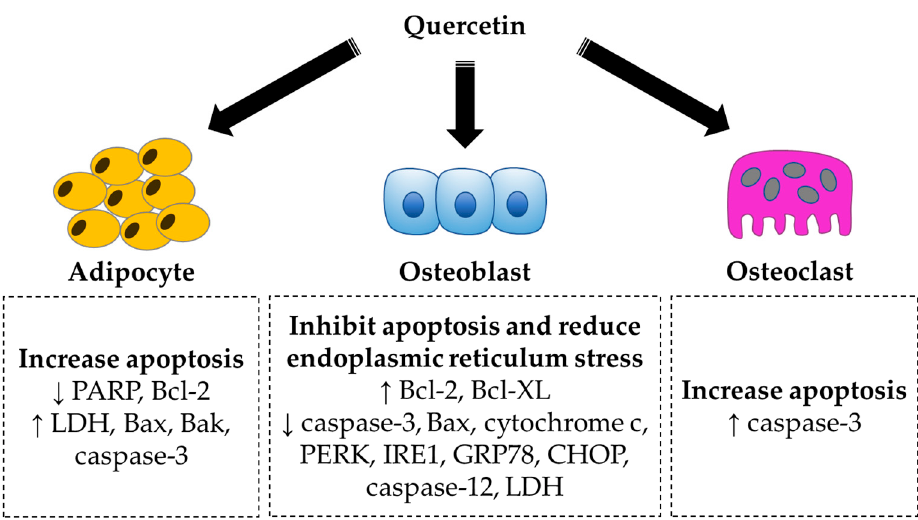
Figure 3. The regulation of apoptosis by quercetin in bone cells. Quercetin induces apoptosis in adipocytes and osteoclasts. In contrast, quercetin inhibits apoptosis and reduces endoplasmic-reticulum-stress-related cell apoptosis in osteoblasts. These actions favour bone formation, thus suggesting the bone-protecting effects of quercetin. Symbol ↑ indicates an increase or upregulation and ↓ indicates a decrease or downregulation. Abbreviations: Bak = Bcl-2 homologous antagonist/killer; Bax = Bcl-2-associated X protein; Bcl-2 = B-cell lymphoma 2; Bcl-XL = B-cell lymphoma-extra large; CHOP = CCAAT/enhancer-binding protein homologous protein; GRP78 = glucose-regulated protein; IRE1 = inositol-requiring enzyme 1; LDH = lactate dehydrogenase; PARP = poly(ADP-ribose) polymerase; PERK = protein kinase RNA-like endoplasmic reticulum kinase.